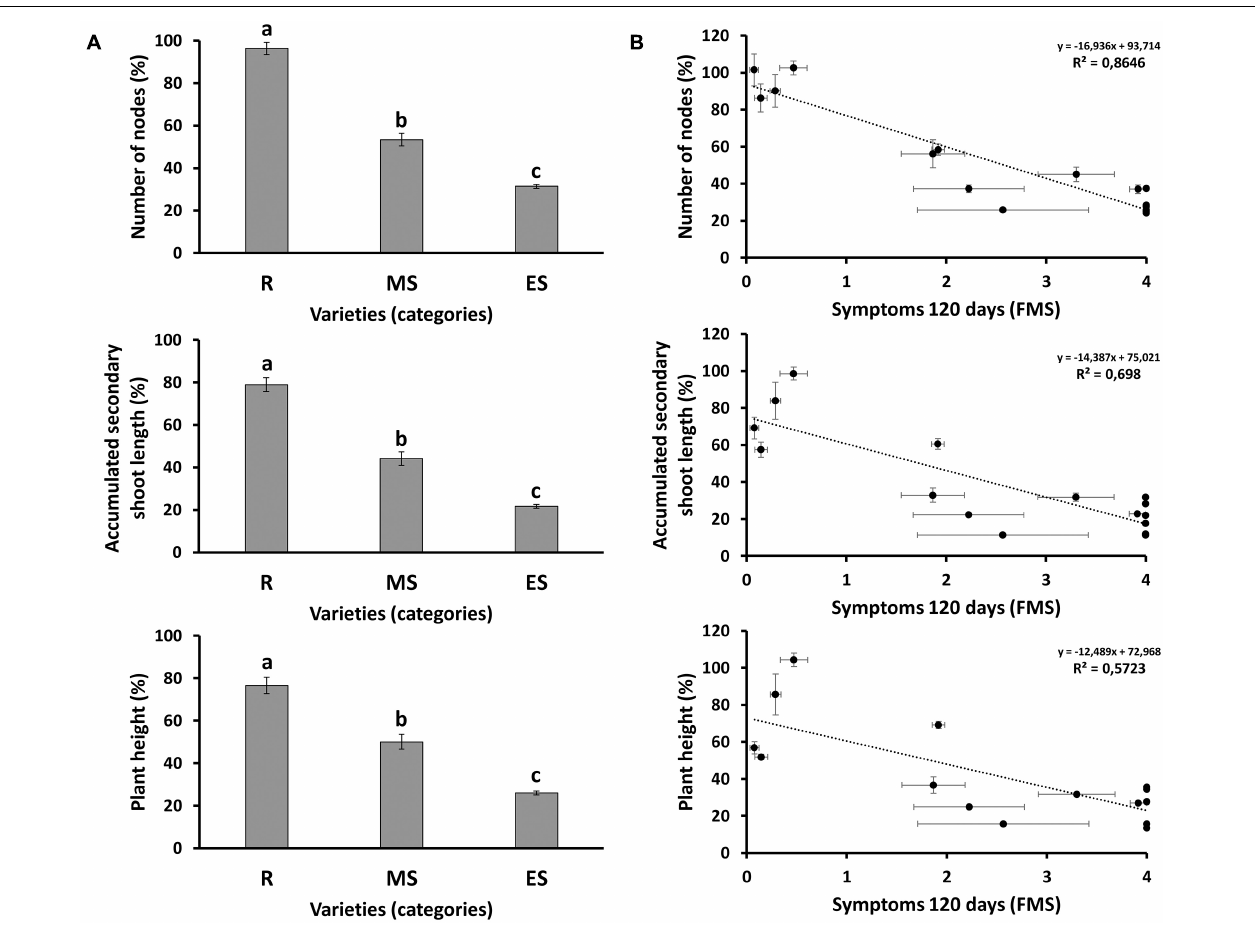
FIGURE 4 | (A) Morphological parameters in different groups of susceptibility at 120 days after inoculation (dai). Results are given as the average value of the different genotypes included in each group of susceptibility: R, resistant genotypes; MS, moderately susceptible genotypes; ES, extremely susceptible genotypes. For each genotype, the morphological value was normalized with the average value of the respective non-inoculated plants. Letters above bars represent significant differences at P < 0.05. (B) Correlations between morphological parameters and symptoms, measured as final mean severity of symptoms (FMS) at 120 dai. Scatter plots including the regression line, the regression equation and the coefficient of determination ( R 2 ) are given for each morphological parameter: number of nodes; accumulated secondary shoot length; and plant height. Bars and dots represent the average value of 12 plants normalized with the average value of the respective non-inoculated plants for each genotype. Error bars correspond to standard errors of the mean.